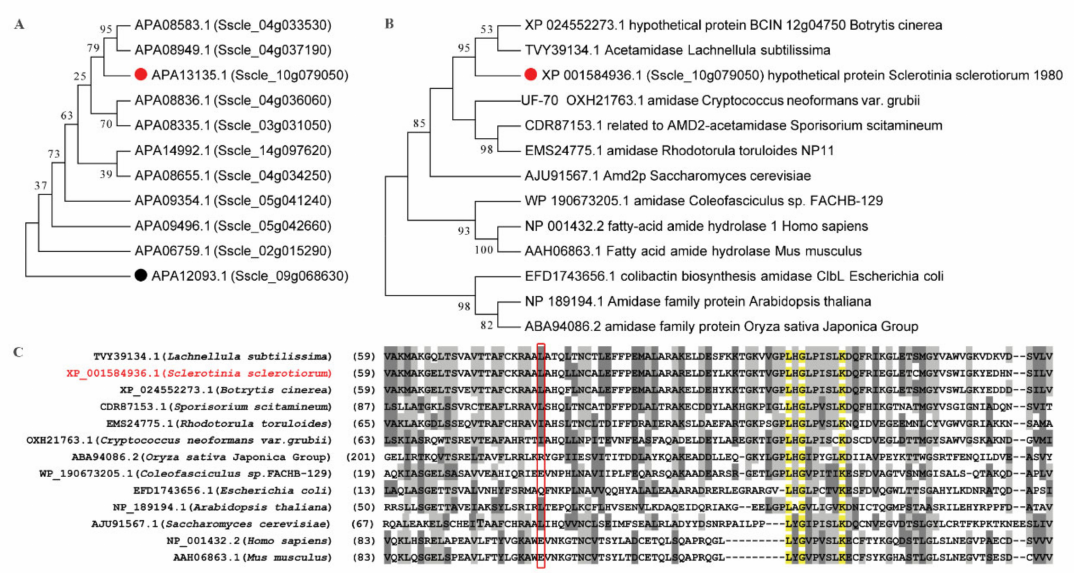
Figure 5. Sequence analysis of Sscle_10g079050 . ( A , B ) The phylogenetic tree was generated by the ML method with bootstrap analysis (1000 bootstrap replicates) using an amino acid sequence alignment of homologous proteins within S. sclerotiorum ( A ) and among different species ( B ). APA12093.1 ( Sscle_09g068630 ), annotated as a hydrolase, was selected as an outgroup. ( C ) Sequence alignment of homologous proteins from different species. Red box represents the homologous region of L82 in Sscle_10g079050 . Numbers indicate the positions of the amino